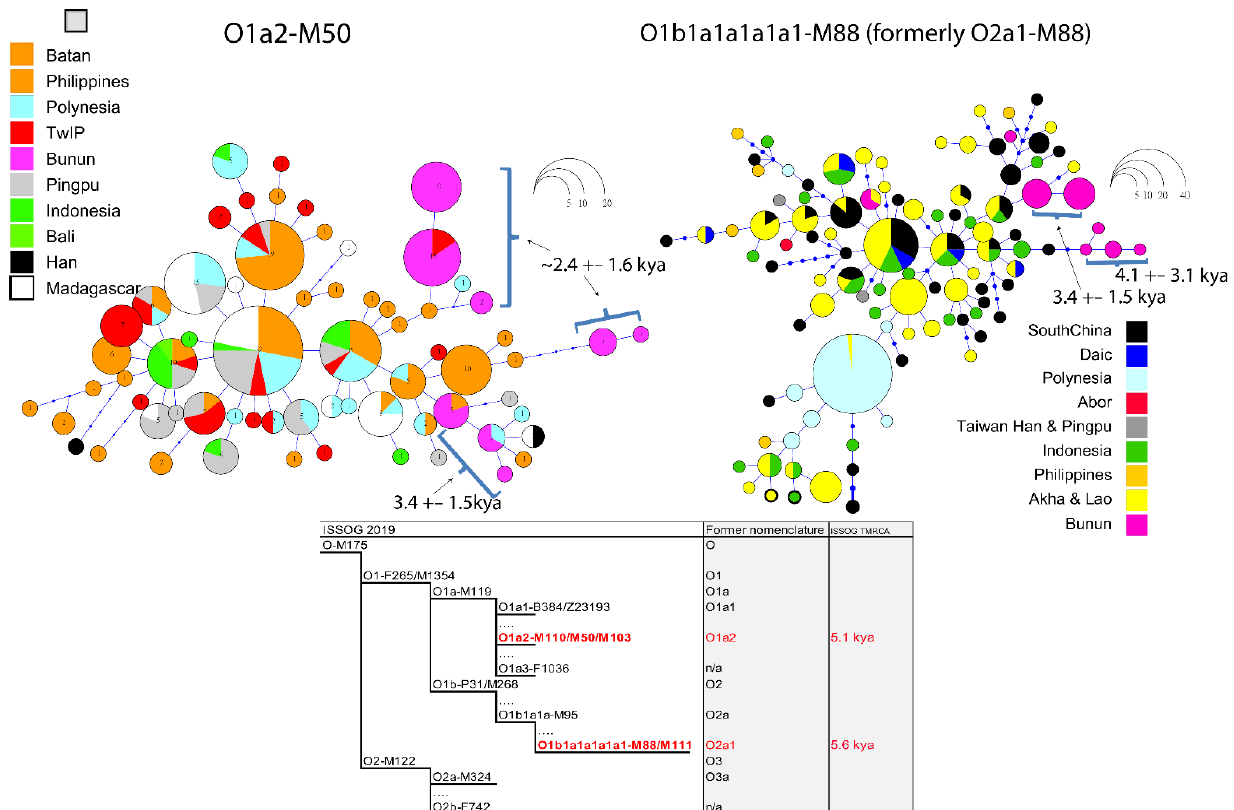
Figure 4. Median joining network of O1a2-M50 and O1b1a1a1a1a1-M88 NRY haplogroups associated with seven Y-STR. The sizes of circles in the networks represent the number of individuals sharing the same haplotype. The lengths of lines between circles are proportional to the mutation steps. Accolades indicate the Northern Bunun age range in kya. The red prints in the ISSOG phylogram (O1a2-M50 and O1b1a1a1a1a1-M88) correspond to the ISSOG 2019 nomenclature of former O1a2-M50 and O2a1-M88 Y-chromosome haplogroups. Pingpu refers to Western plain dwellers of Taiwan (Pazeh and Siraya). Akha and Lao represent groups of Mainland Southeast Asia. Oceania represents the dataset of Delfin et al. 2011 [42] (e.g., Tonga, Samoa, Fiji).